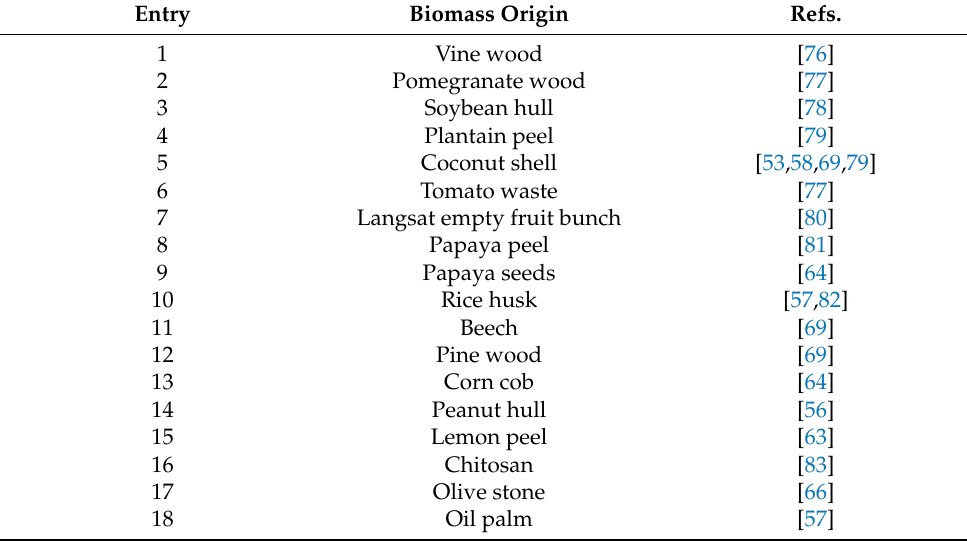
Table 1. Summary of the different activated carbons